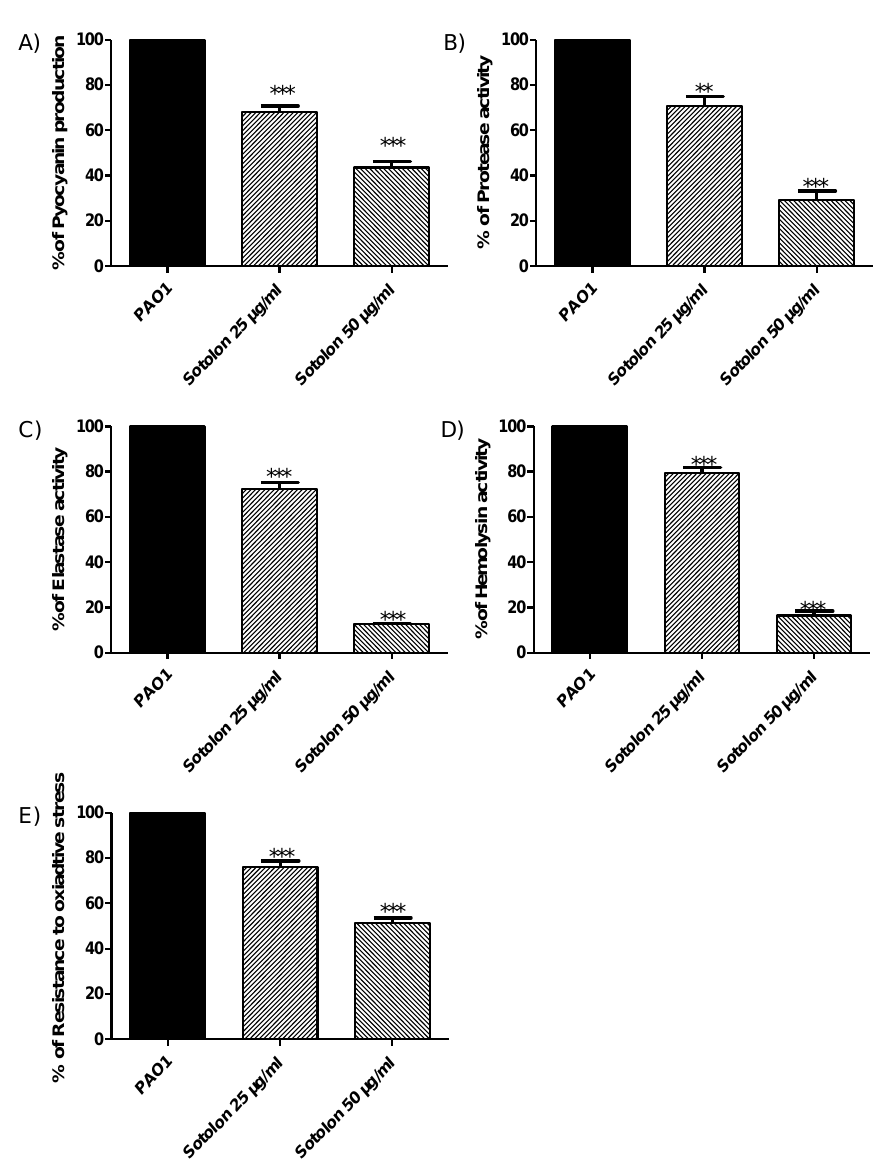
Figure 2. Inhibition of PAO1 virulence factors by sotolon. PAO1 cultures were prepared with and without Sotolon sub-MIC (1/4 and 1/8 MIC). One-way ANOVA test (Graphpad Prism 8 software) was utilized to compare between the results of sotolon sub-MIC treated and untreated PAO1 cultures. The results were considered statistically significant when p values < 0.05. The data obtained were presented as mean ± standard error of percentage change from untreated cultures. ( A ) Pyocyanin production: sotolon in sub-MIC significantly reduced the production of pyocyanin ( p < 0.0001). ( B ) Protease production: sotolon significantly reduced the production of protease, p = 0.0022 and p < 0.0001 in 1/4 MIC and 1/8 MIC, respectively. ( C ) Elastase production: elastase was significantly reduced in the presence of sotolon in sub-MIC ( p < 0.0001). ( D ) Hymolysins production: Sotolon significantly diminished the hemolytic activities of POA1 strain ( p < 0.0001). ( E ) Resistance to oxidative stress: sotolon in sub-MIC significantly enhanced the sensitivity to oxidative stress ( p < 0.0001). ** = p < 0.01, *** = p < 0.001.